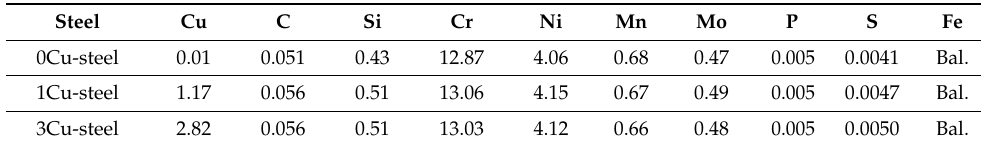
Table 1. Chemical compositions of the three steels studied